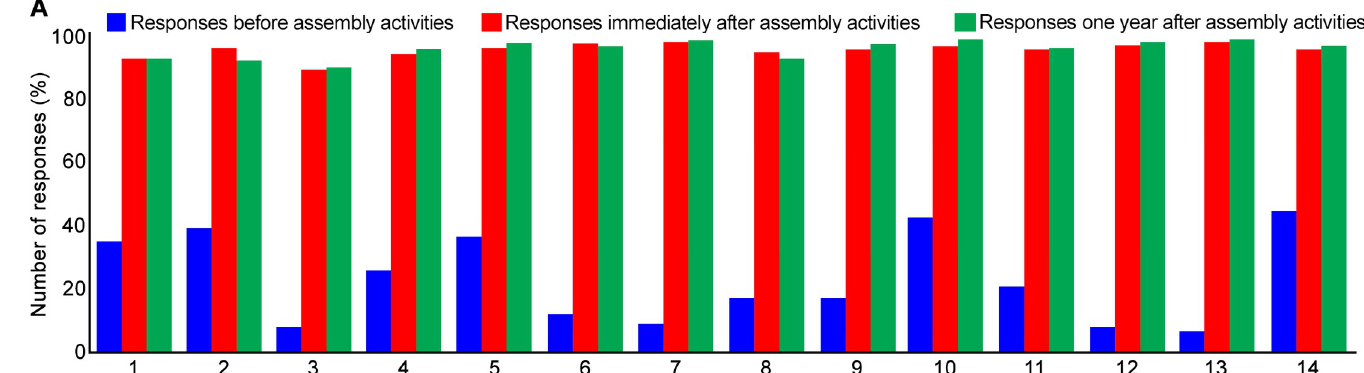
Fig 5. Key message recall among rural people. Responses to the study questionnaire before (blue) and after (red) our SBE activities (n = 2,418). Similarly, responses to the study questionnaire after 12 months (n = 413) (green) were also recorded. The number of correct answers were converted into percentages for easy comparison. The numbers on the X axis indicate the questions used in the questionnaire, as listed in Fig 4.